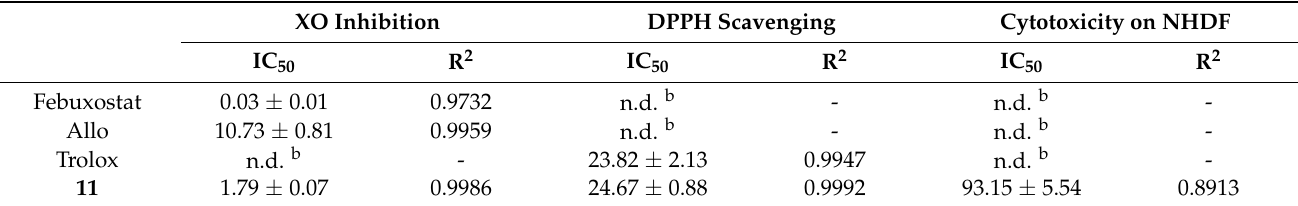
Table 2. In vitro IC 50 values ( µ M) for XO inhibition, DPPH radical scavenging activity and cytotoxicity on NHDF cell line of bis-thiobarbiturate 11 and respective references Allo and Trolox a